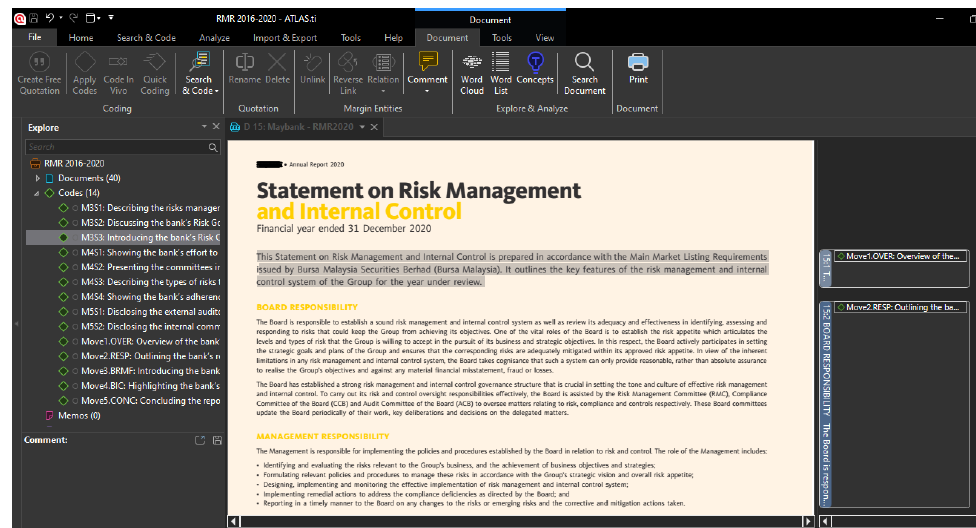
Figure 1. Move annotation using Atlas.ti 22.